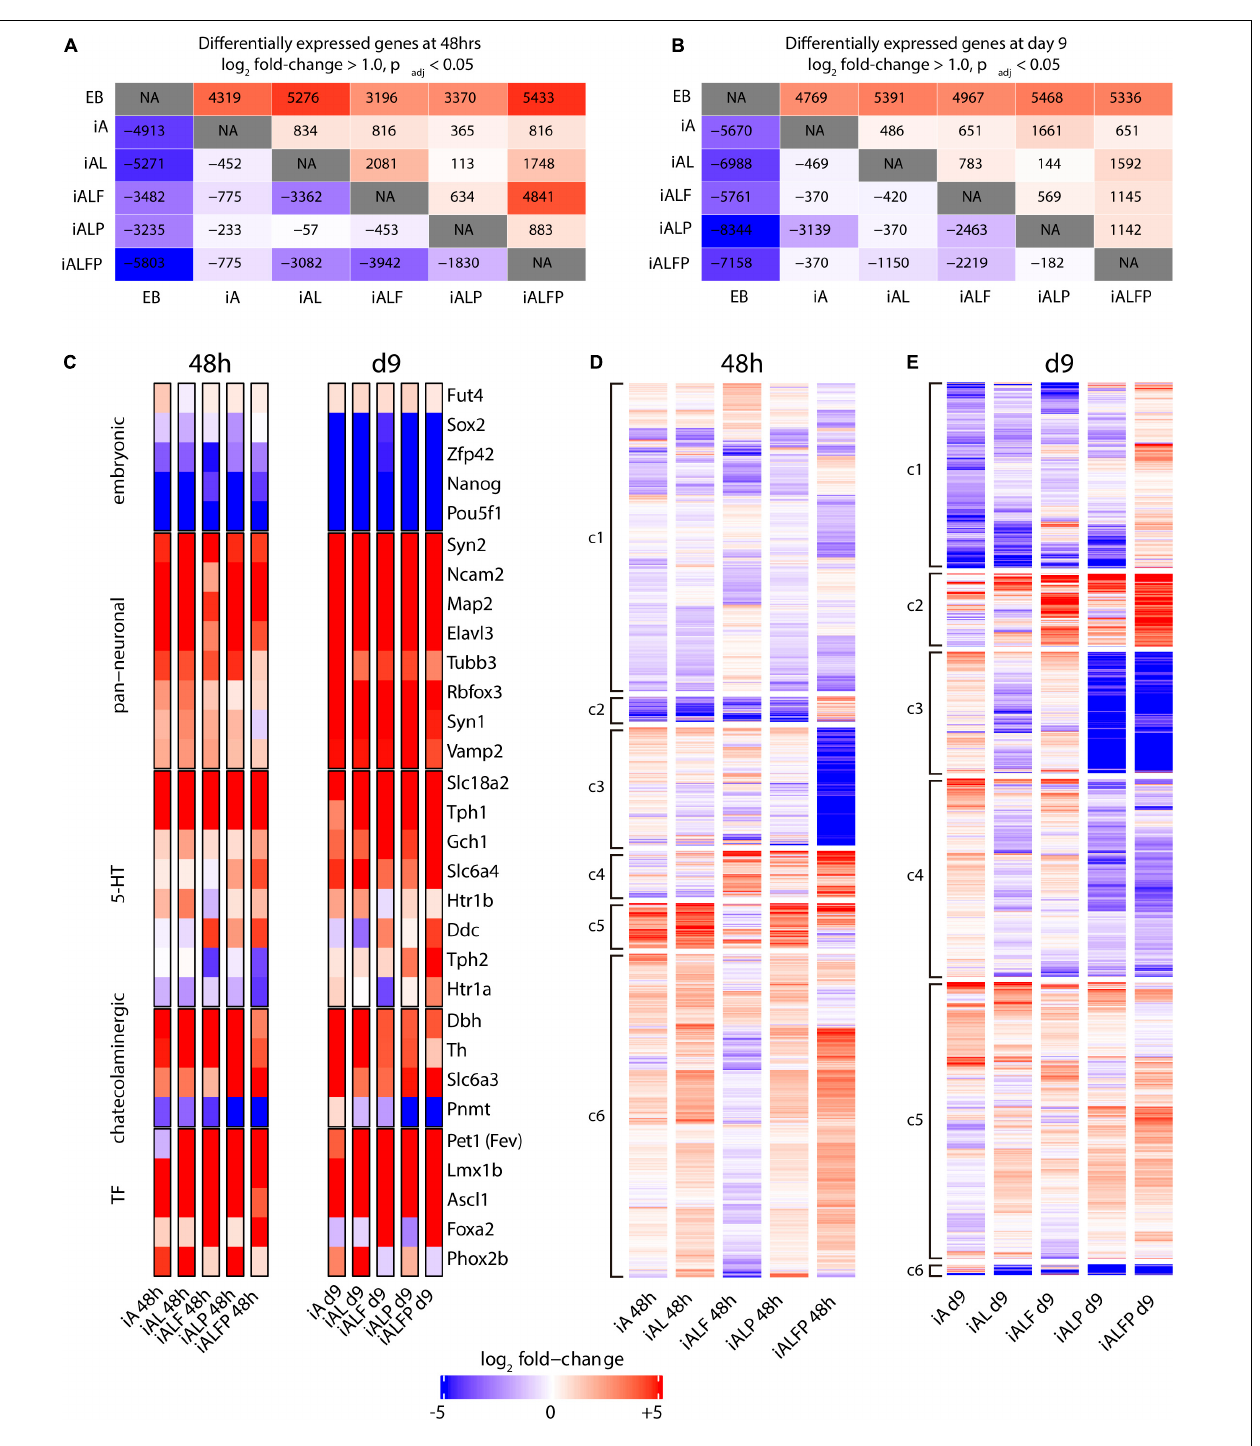
FIGURE 2 | Transcription profile of induced neurons at differentiation days 2 and 9. A, B. Counts of up- and downregulated genes under different exogenous transcription factor constructs at 48 h (A) and 9 days (B) post-induction. Conditions were compared in a pairwise fashion using DESeq2. The upper half of the diagonal is upregulated genes, the lower half is downregulated genes. (C) Heatmap of diagnostic gene expression at 48 h and 9 days post TF induction. Slc18a2 a.k.a. Vmat2; Slc6a4 a.k.a. Sert; Slc6a3 a.k.a. Dat. (D,E) Bulk RNA-seq heatmaps under different exogenous transcription factor constructs at 48 h (D) and 9 days (E) post-induction. At each timepoint, genes that were either upregulated or downregulated in all five conditions were removed, and genes that did not have a log fold change of at least 1.0 with an adjusted p -Value of 0.05 according to DESeq2 in at least one of the five transcription factor conditions were also removed, leaving 6393 genes at 48 h and 3970 genes at day 9. These remaining genes were clustered using K-means clustering using the R kmeans function. Transcripts were assigned to six clusters (c1 to c6) based on the expression pattern across all conditions.